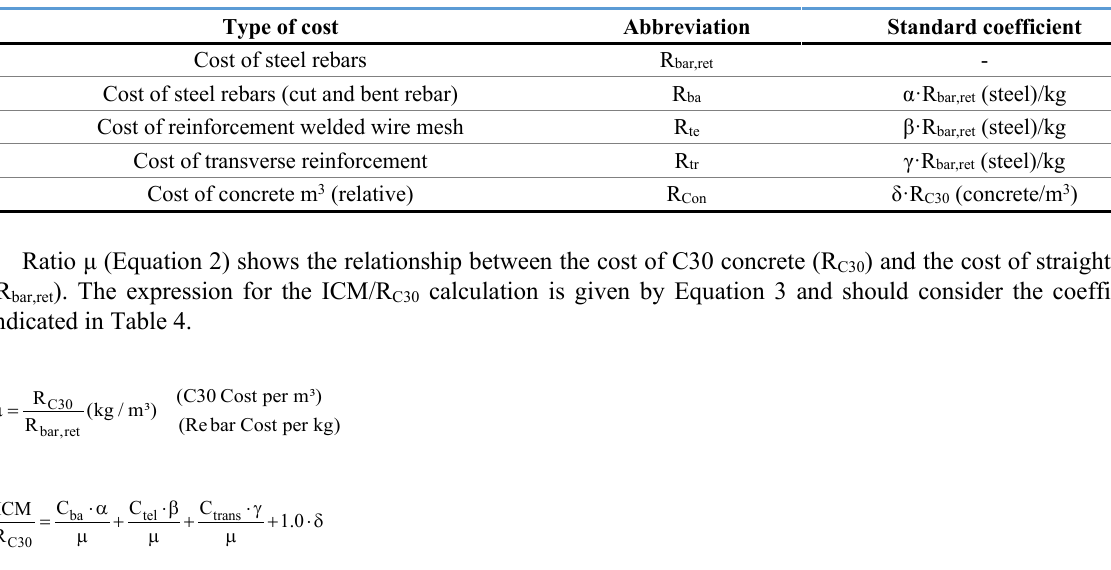
Table 4. Coefficients for the ICM